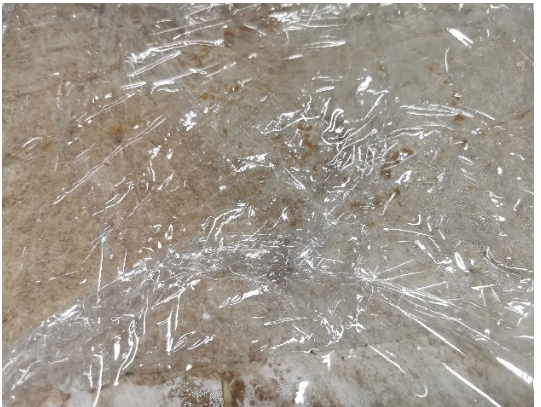
Figure 6. Mycelium-based material during growth (design and photo: A. Bonenberg).